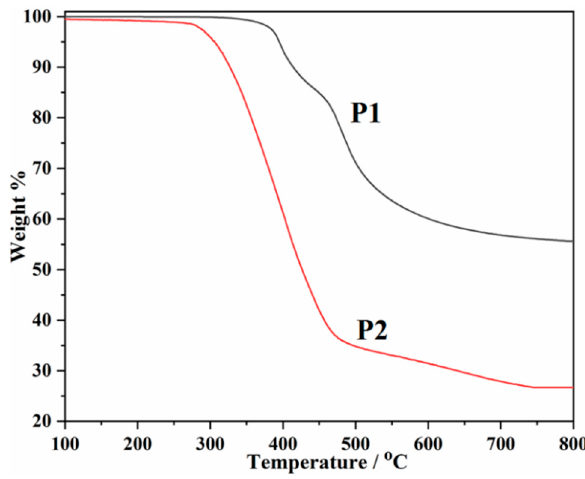
Figure 5. TGA curves for double-stranded P1 and single-stranded P2 .